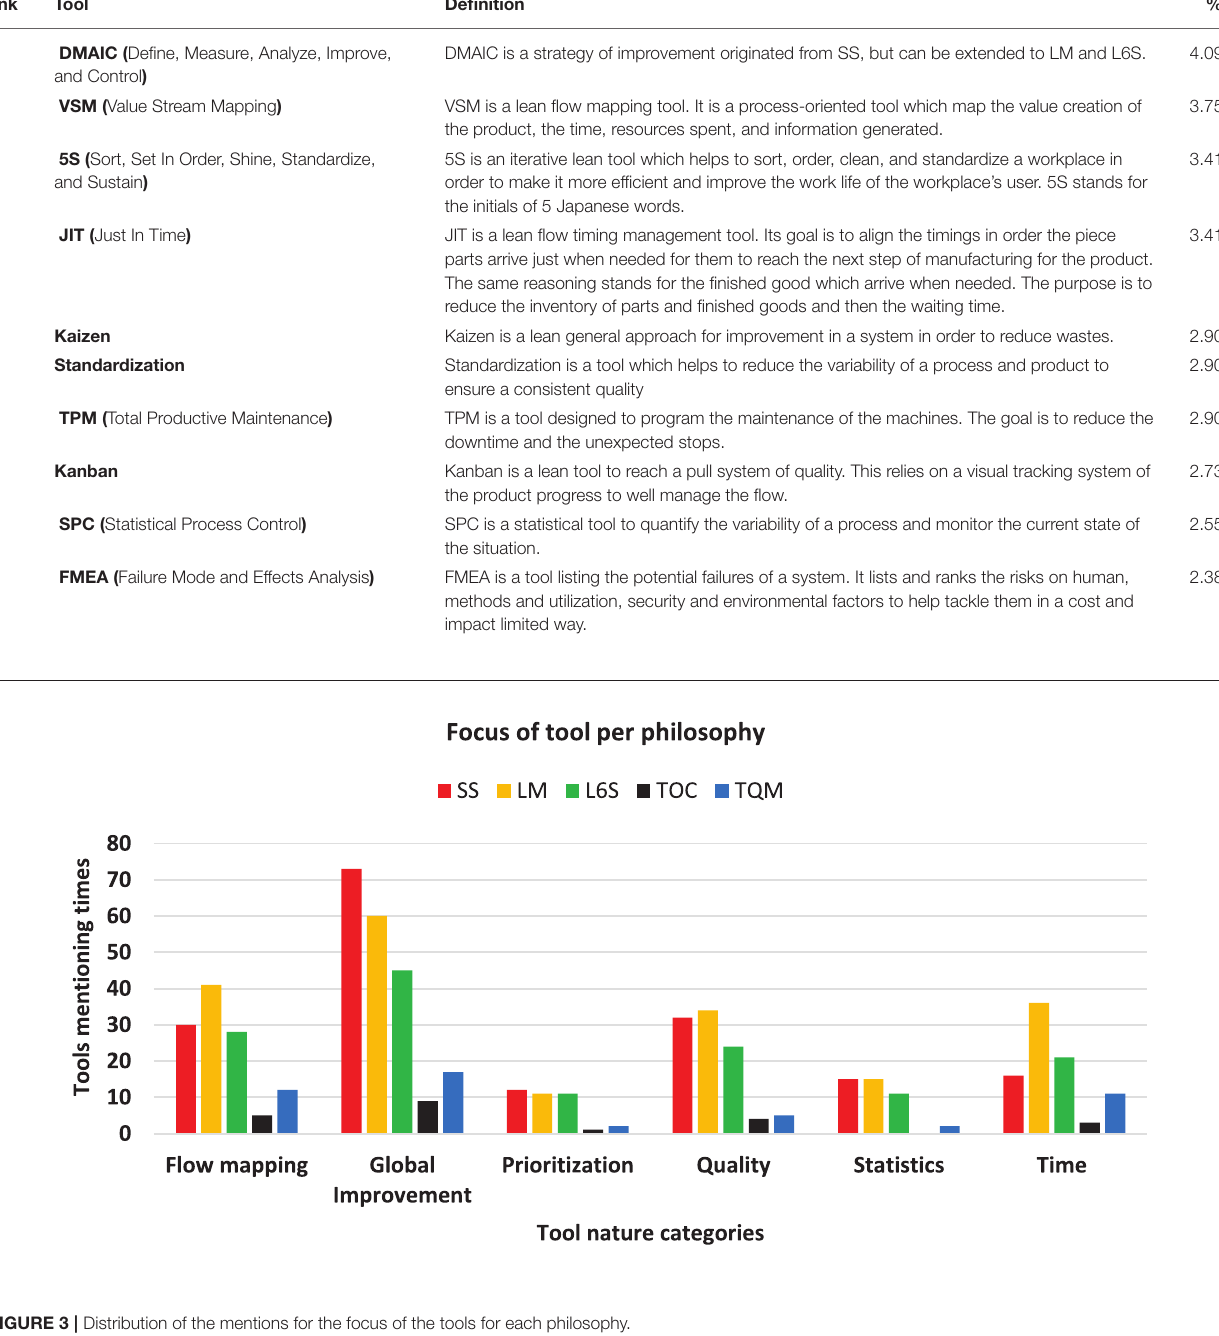
prioritization of the improvement to make with 6.31% of the category